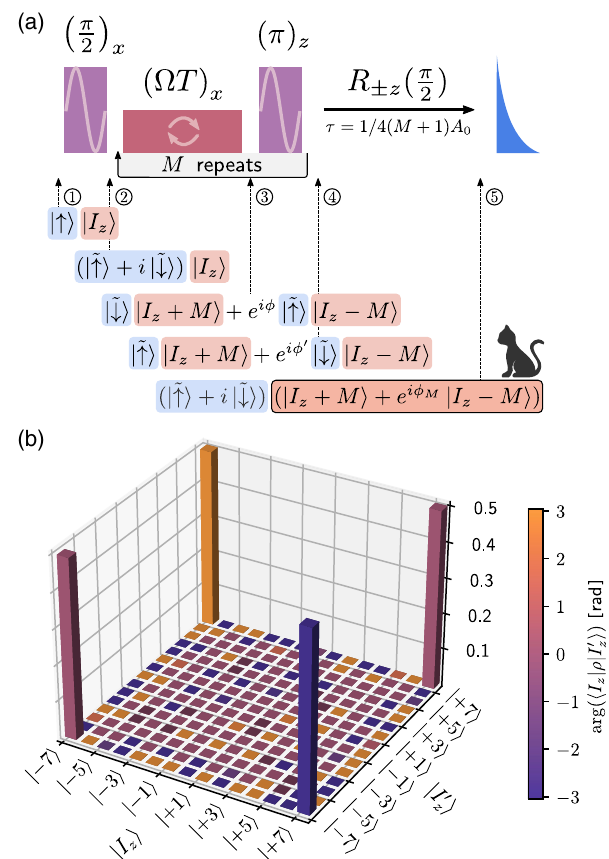
FIG. 16. Simulating Schrödinger kitten-state generation. (a) A copy of Fig. 5 of the main text. Pulse sequence representing the proposed kitten-state protocol. Square pulses depict coherent qubit control pulses. The blue shape represents dissipative reset of the electron. We write down the electron-nuclear state at each step. (b) Representation of the final density matrix ρ after the protocol, with M ¼ 7 , is applied in the I ¼ 7 manifold of nuclear states. The electron has been traced out of the density matrix. The height and color of each bar represent the absolute value and argument of each matrix element,